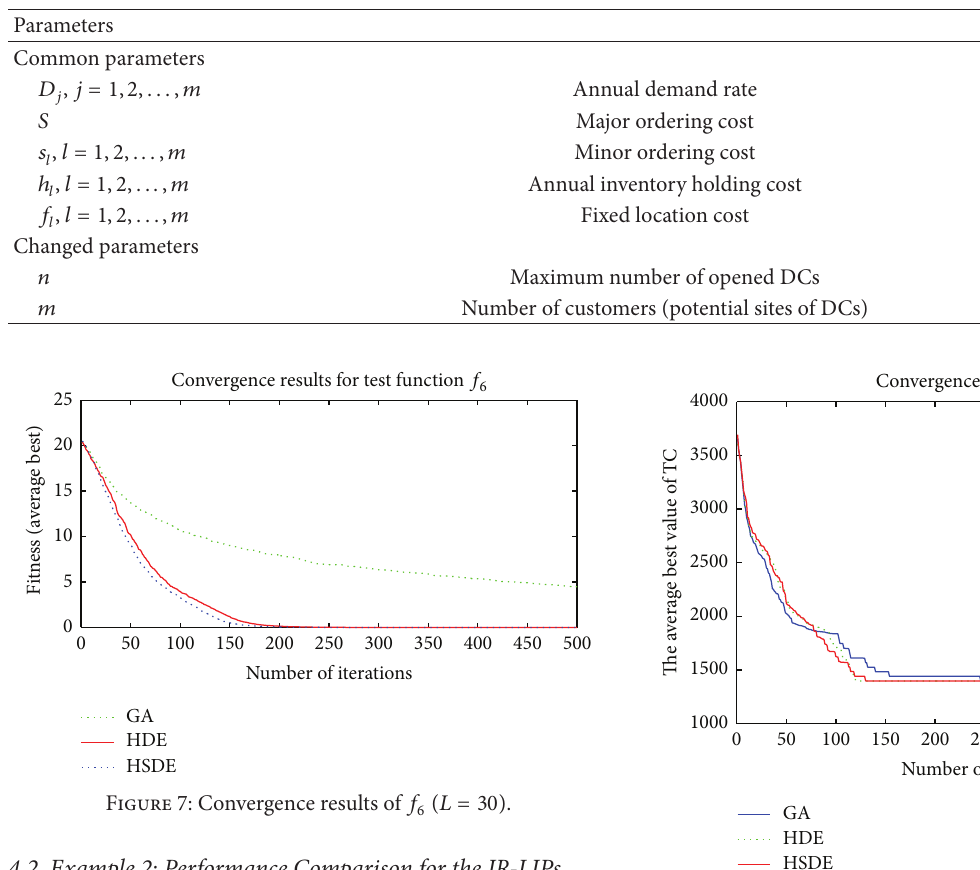
Table 5: Parameters for test problems.